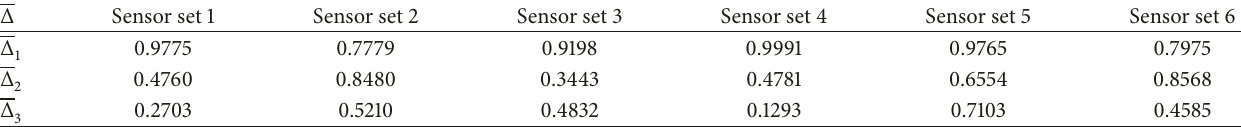
Table 5: The mean values of Δ with 10% measurement noise.